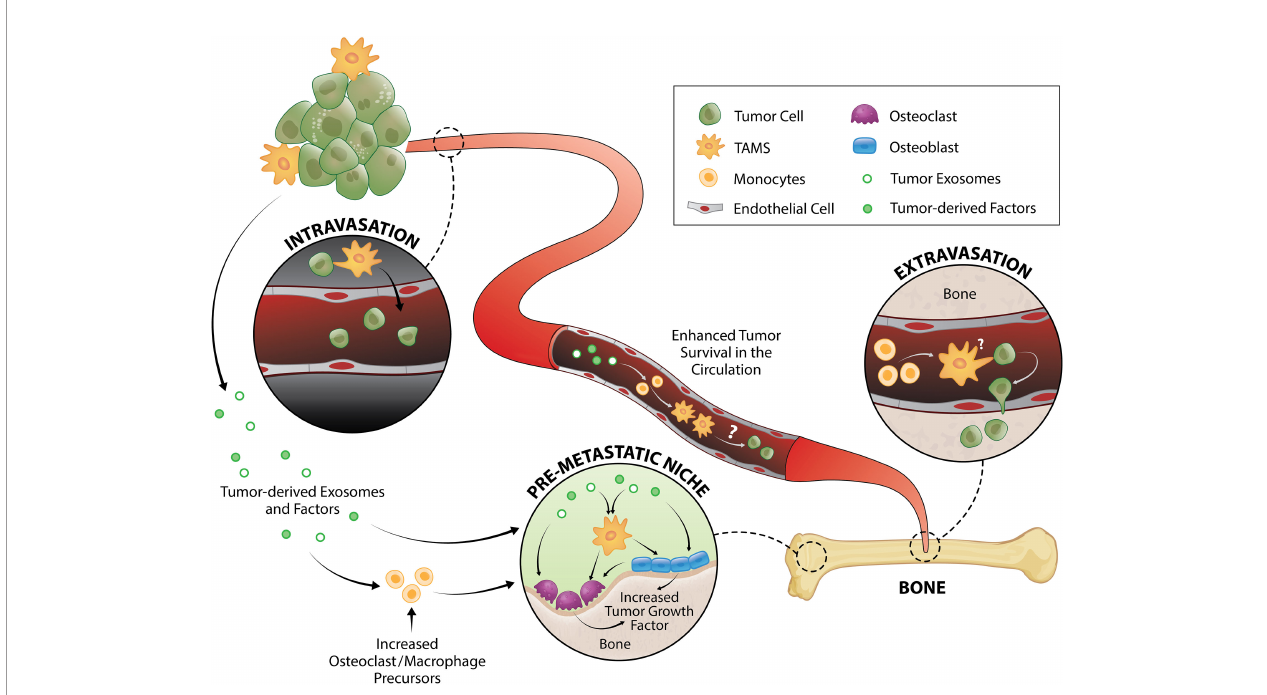
FIGURE 1 | TAM and tumor crosstalk promotes the early metastatic cascade. TAMs contribute to tumor intravasation, extravasation and pre-metastatic niche formation. Direct interaction between TAMs and tumor cells induce migration from primary tumor site to the vessel wall and subsequently, tumors egress into the circulation where they generate fragments that recruit macrophages and monocytes required for successful early metastasis. Tumor-derived exosomes and factors also trigger pre-metastatic niche formation directly or by enhancing monocyte/macrophage recruitment that serves as osteoclast precursors or stimulate osteoblast function, both of which result to release of a myriad of tumor growth